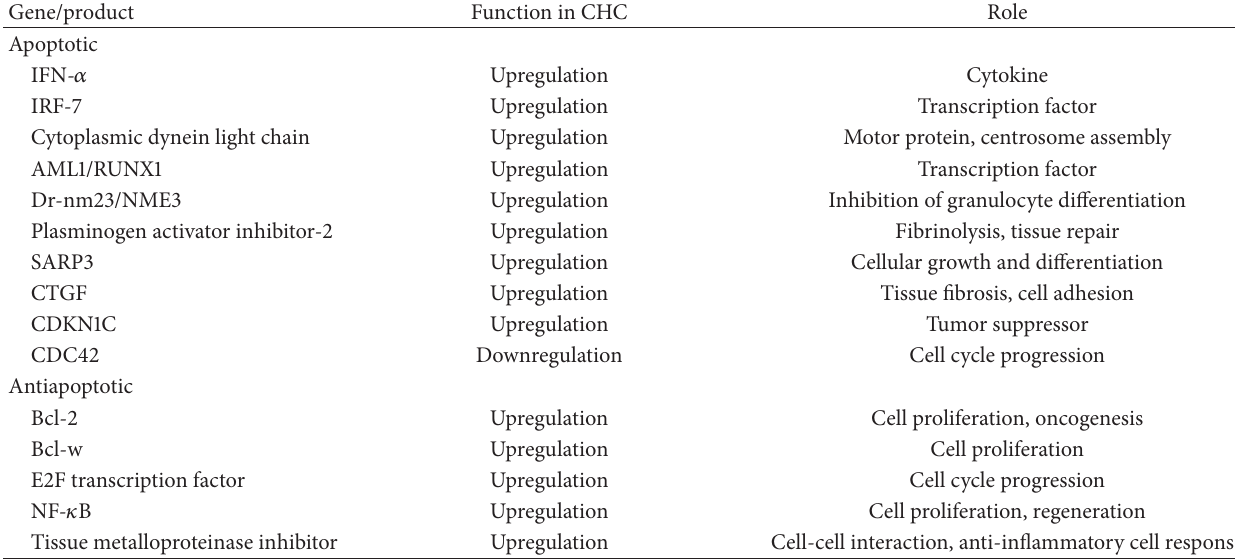
Table 1: Apoptotic and antiapoptotic gene expression in chronic HCV-mediated liver injury and